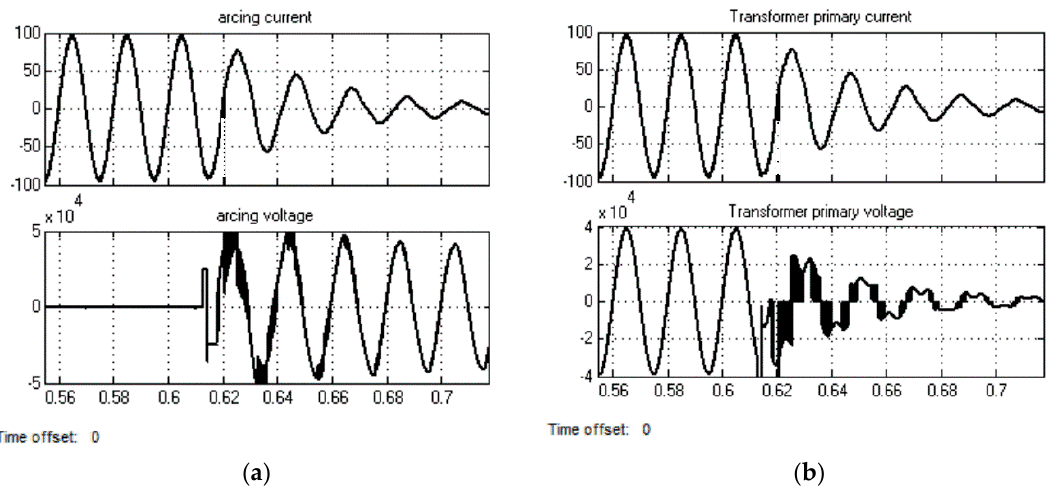
Figure 11. Simulation result of the proposed method. ( a ) The current and voltage waveforms of the Cassie arcing model. ( b ) The current and voltage waveforms of the transformer primary side.